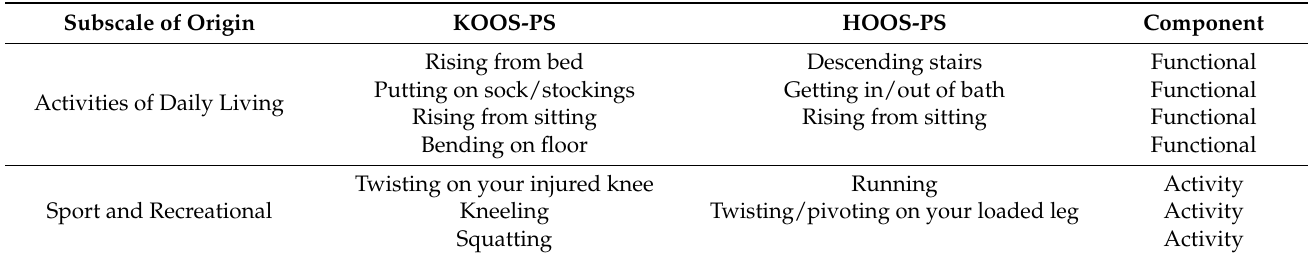
Table 4. Items in the HOOS-PS and KOOS-PS and their subscale of